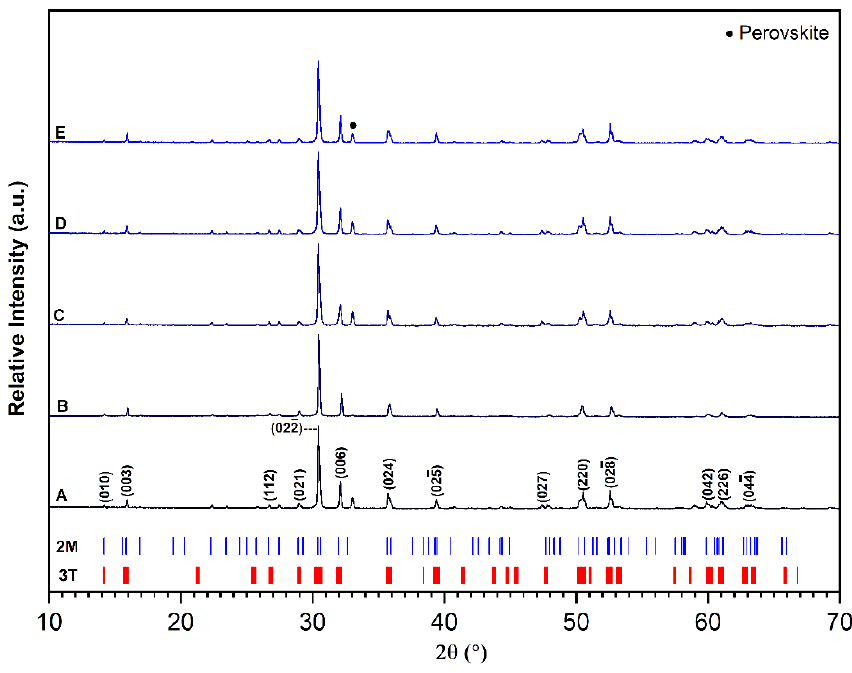
Figure 1. Powder XRD data for HIPed Samples A – E. Zirconolite-2M and -3T reflections are indexed with corresponding (hkl) values of zirconolite-3T.